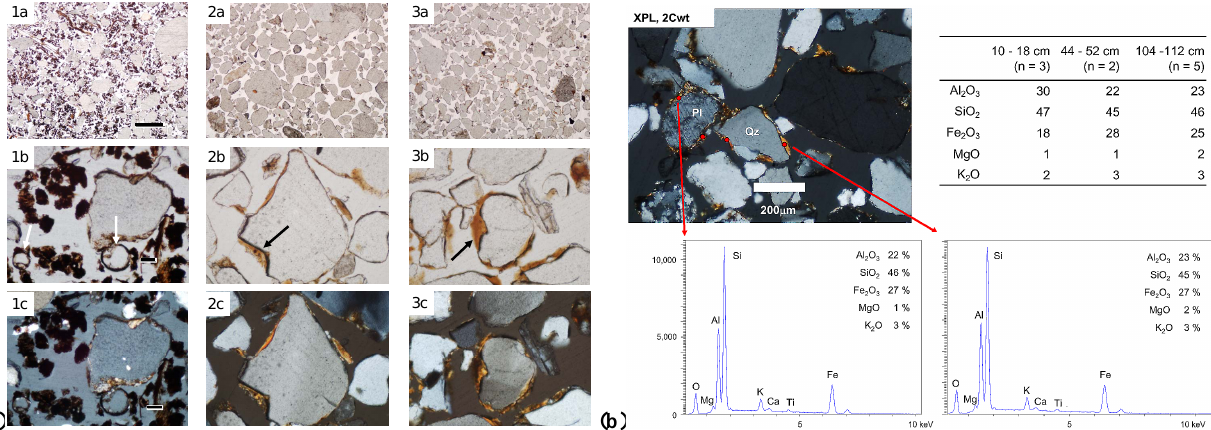
Fig. 5. (a) Micromorphological properties of soil horizons; microstructure (a, b=PPL, c=XPL) of selected soil horizons: (1) AE (0–2cm), arrows point to testate amoebae; (2) Bw 1 (44–51cm), arrow points to Fe-oxides/clay coating; (3) 2Cwt (104–112cm), arrow points to Fe-oxides/clay coating; widths of photo: 1a, 2a, 3a=6mm; other=0.6mm. (b) SEM-EDX micrographs of cutans in 2Cwt (104–112cm); average chemical composition (wt.-%) of coatings of different depths analysed by electron microprobe; number in brackets=no. of cutans analysed by EDX in each thin section.